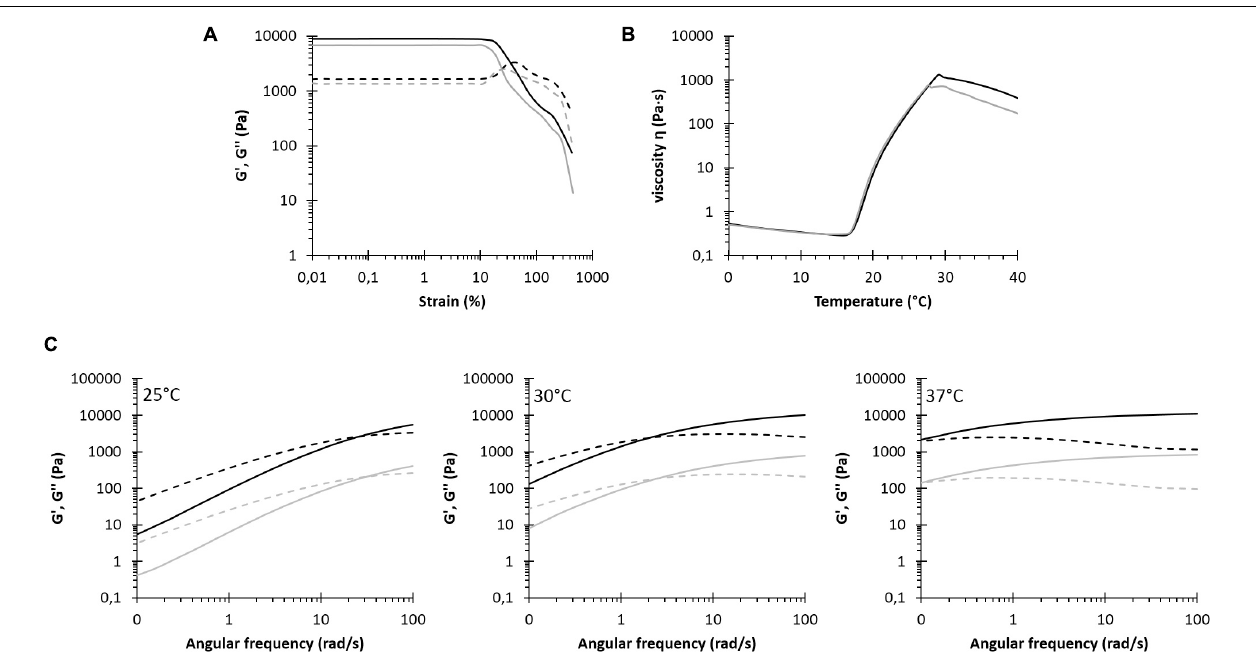
FIGURE 1 | Rheological characterization of NHP407 (black) and SHP407 (gray) hydrogels. (A) Storage (G (cid:48) , continuous line) and loss (G (cid:48)(cid:48) , dashed line) moduli trends as a function of applied strain at 37 ◦ C. (B) Trend of viscosity ( η ) as a function of temperature within 0–40 ◦ C temperature range. (C) G (cid:48) and G (cid:48)(cid:48) trends (continuous and dashed lines, respectively) as a function of angular frequency at 25, 30, and 37 ◦ C. G (cid:48) and G (cid:48)(cid:48) values of SHP407 hydrogels were divided by a factor of